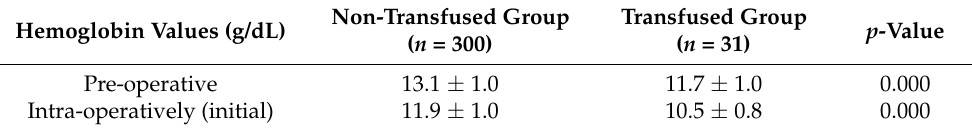
Table 6. Hemoglobin values of transfused and non-transfused patients. Non-Transfused Group Hemoglobin Values (g/dL)